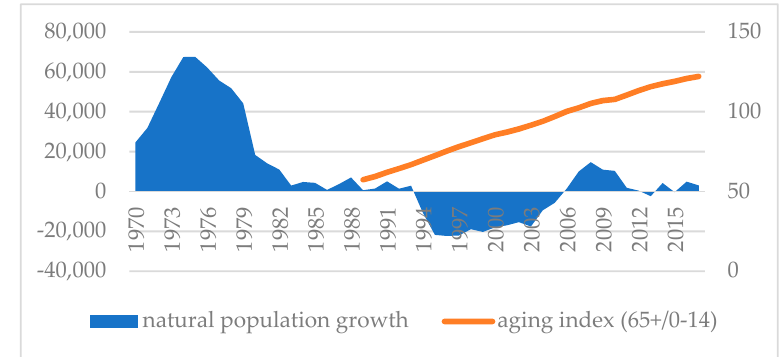
Figure 2. The trend in natural population growth between 1970 and 2016 (left axis) in the number of people; aging index trend between 1989 and 2016 (right axis) in %.